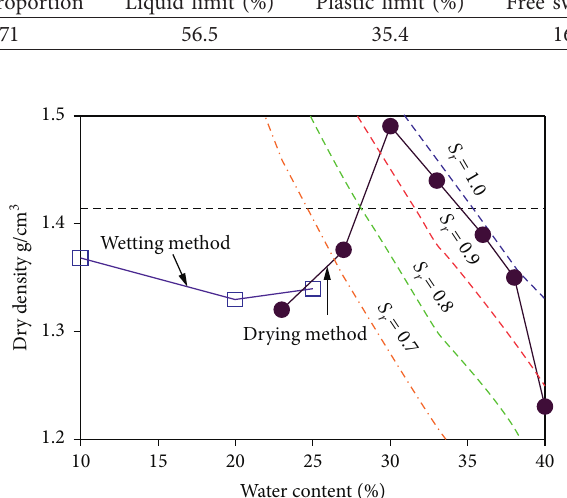
Figure 1: Compaction curves of laterite.